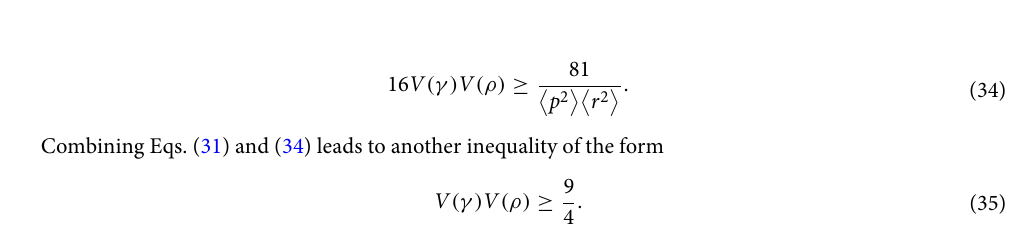
Figure 3. Shannon entropy for position space against the equilibrium bond length with µ = ℓ = (cid:31) = 1, n = D e = (cid:31) = 1, and C = (cid:31) of the multiple potential